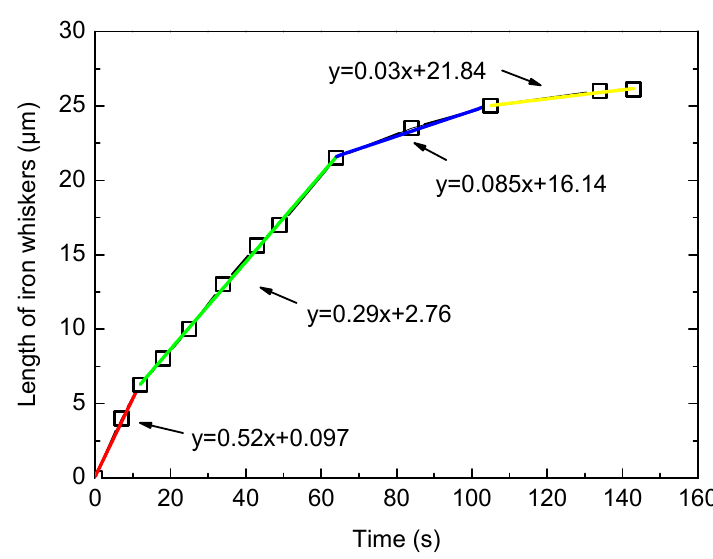
Figure 13. The relationship between the length of the iron whisker and the growth time.